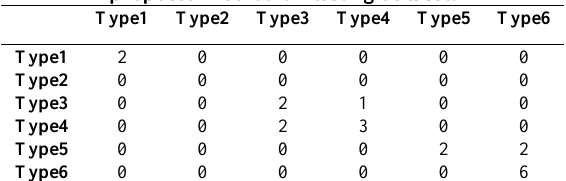
Table 1. Values obtained for Kappa coefficient by proposed method on testing dataset.